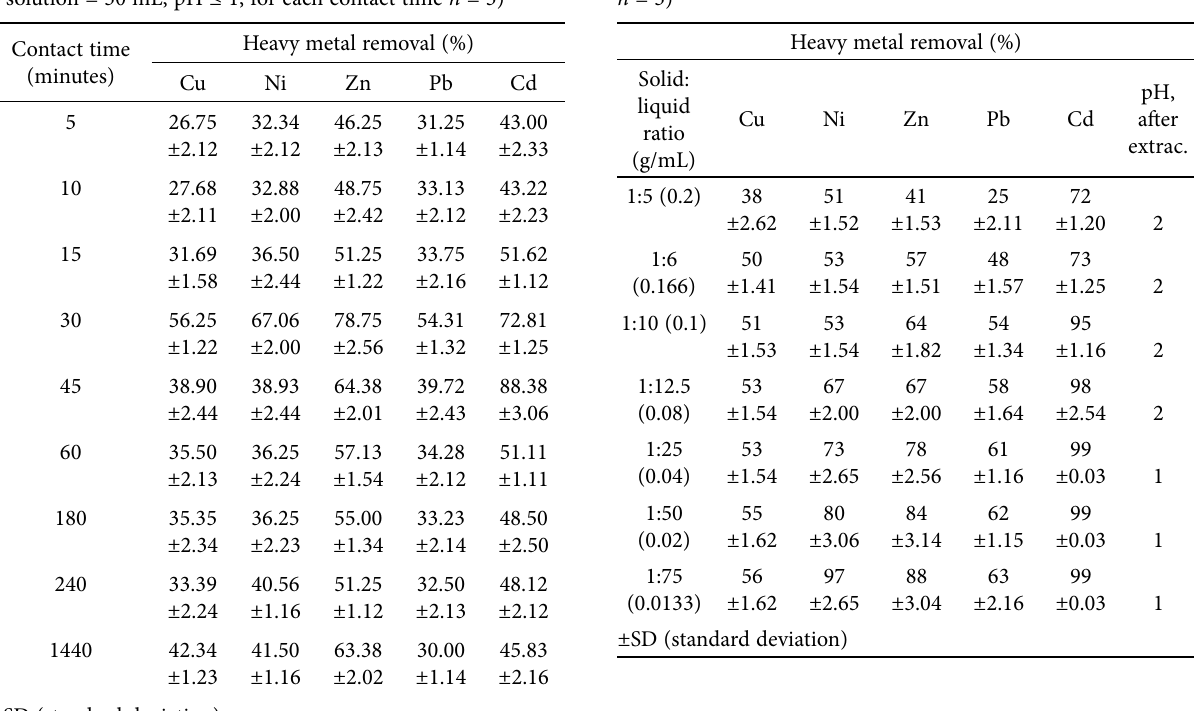
Table 7. Results of specific solid–liquid ratios (t = 1 hour; pH